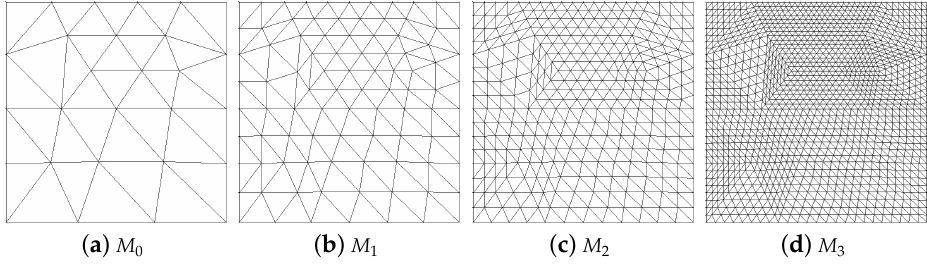
Figure 1. The initial mesh ( a ) M 0 and and the first three level meshes ( b ) M 1 , ( c ) M 2 , ( d ) M